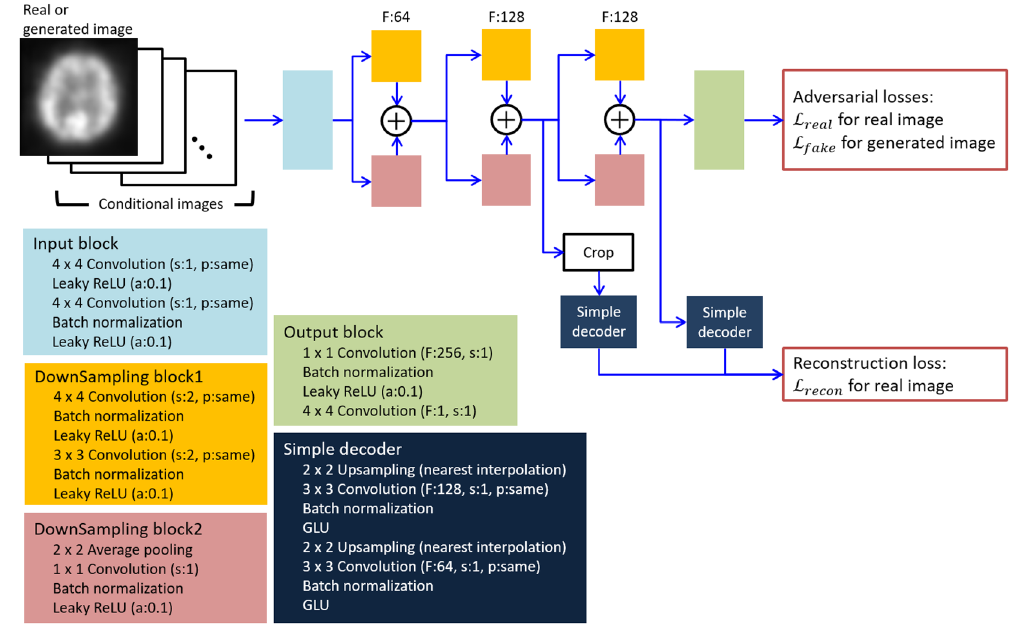
Figure 3. Discriminator in our model. The discriminator uses as input the real or generated image with the conditional image representing the pattern of radiotracer accumulation. Symbols F, s, p and a denote channels of output feature maps, strides, padding and slope of Leaky ReLU activation function, respectively. For padding, the “same” indicates that padding is applied to the input feature map so that the height and width of the